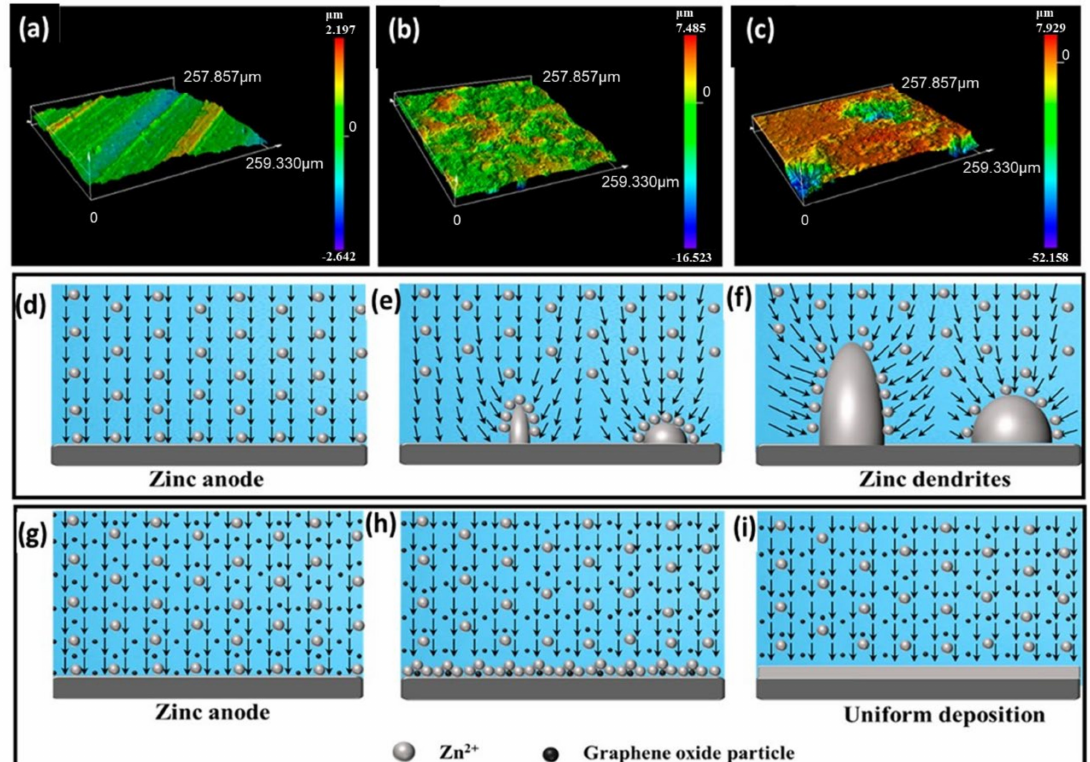
Figure 5. 3D laser images of ( a ) the untouched zinc anode, ( b ) the zinc anode without GO additive, and ( c ) the zinc anode with GO additive after cycling. The electric field dispersal on the zinc anode ( d – f ) surface without GO electrolyte additive and ( g – i ) with GO electrolyte additive. The vectorial field describes the direction of the electric field. Reprinted with permission from Ref. [56]. Copyright 2021 American Chemical